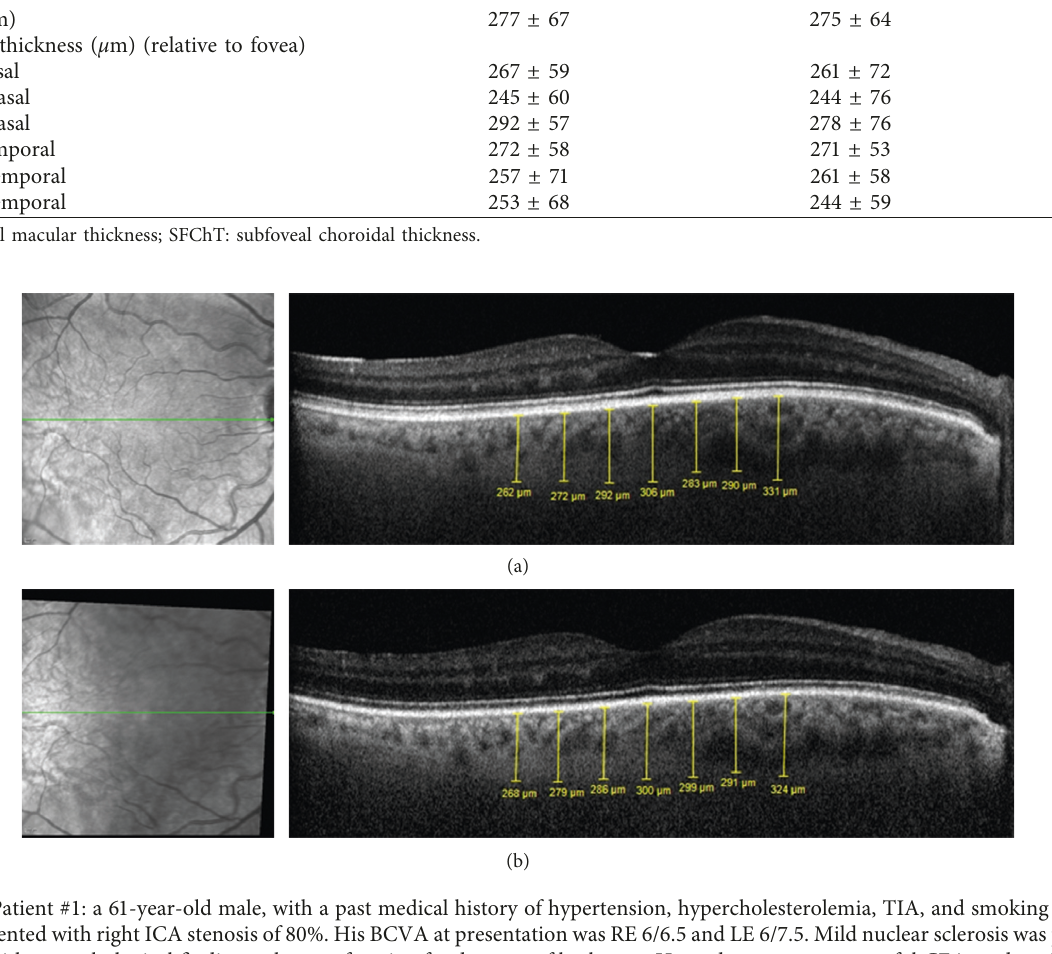
Table 4: CMT and SFChT before and after carotid artery endarterectomy. Before endarterectomy After endarterectomy p value